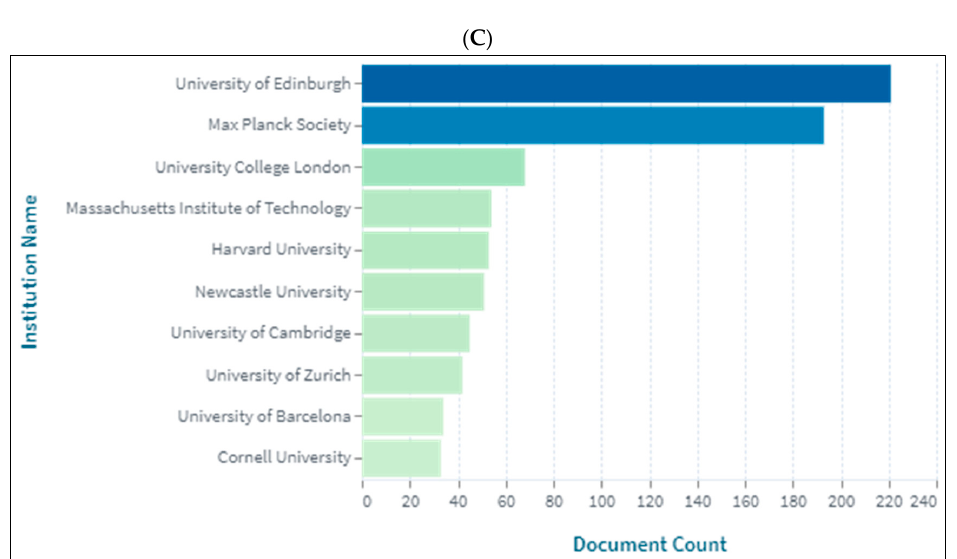
Figure 3. Knowledge production size in biolinguistics by university/research centre. ( A ) (Scopus), ( B ) (WOS), ( C ) (Lens).